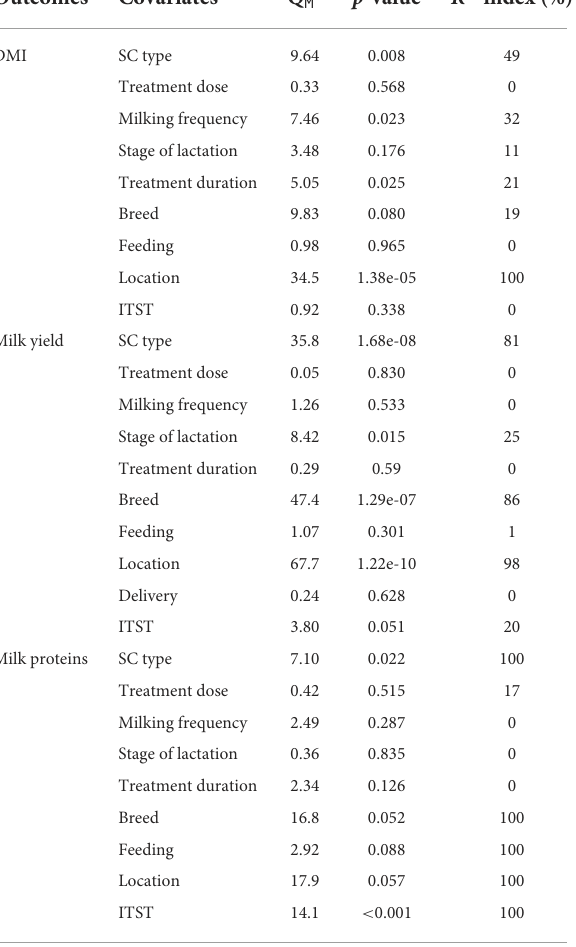
TABLE 7 Relationships between covariates and outcome measures (milk fat, lactose and total solids). Outcomes